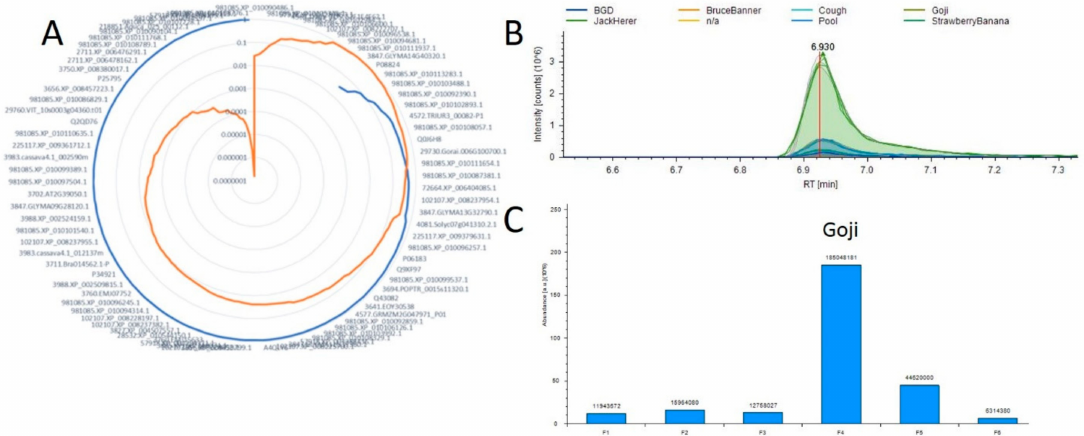
Figure 4. Example correlation analysis plot ( A ) Radar diagram for 11-OH-THC where the blue line represents all positive Pearson Correlation and orange is the p-value for each measurement. ( B ) A plot overlaying the 11-OH-THC metabolite peaks and technical replicates. ( C ) A plot of the protein from A demonstrating the highest correlation with this